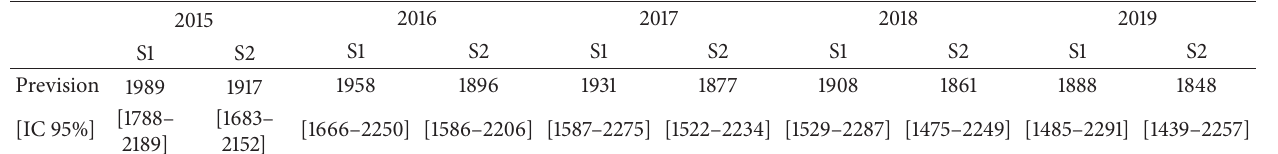
Table 2: Forecasted number of tuberculosis patients predicted to be diagnosed between 2015 and 2018 in